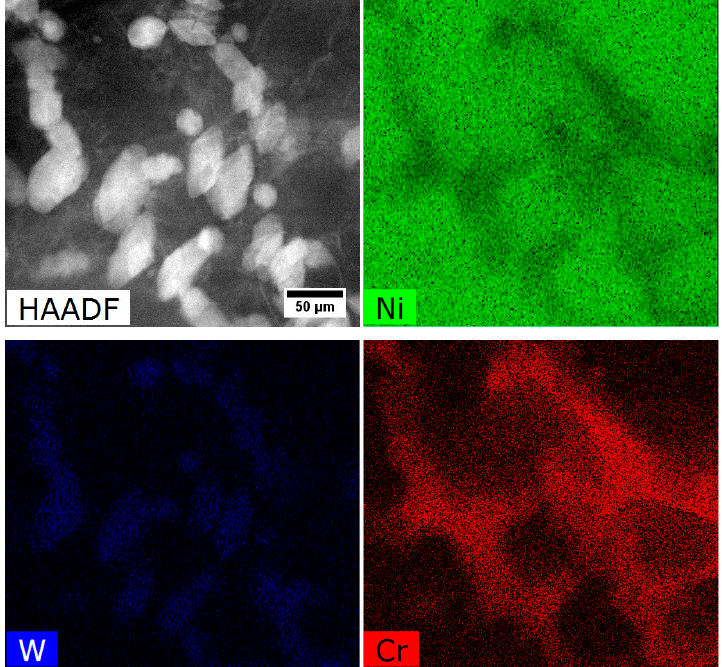
Figure 21. Distribution of selected alloying elements at a grain boundary, STEM-EDX. Materials 2020 , 13 , x FOR PEER REVIEW